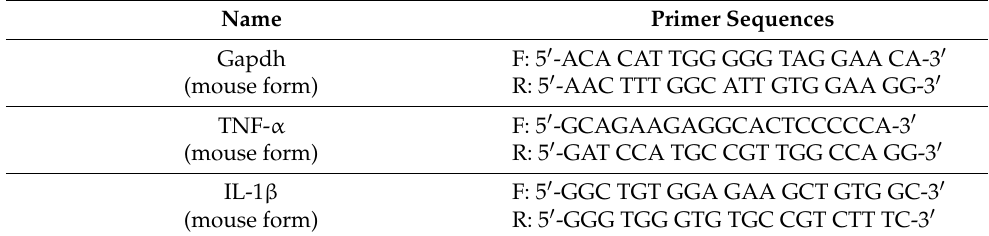
Table 1. Primer sequences used for the